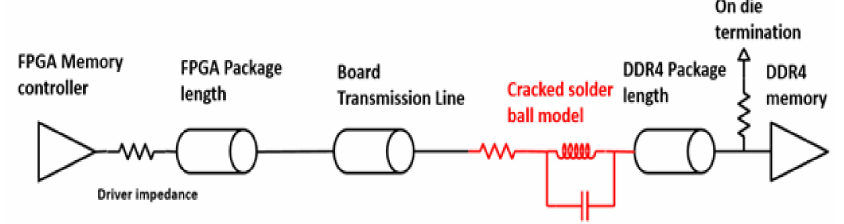
Figure 3. Diagram of simulation setup.